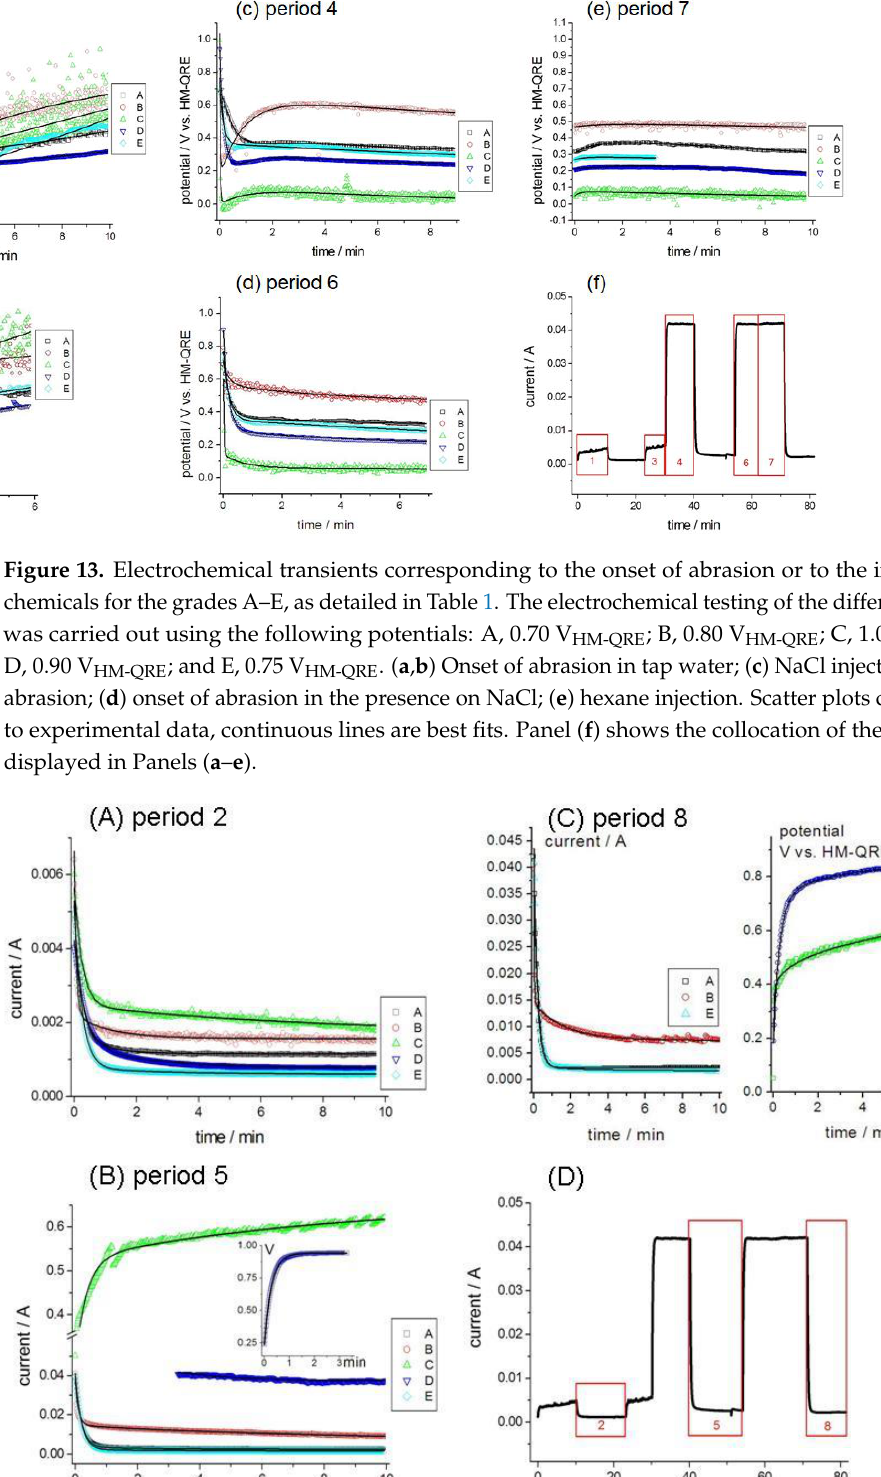
3.3 for details.